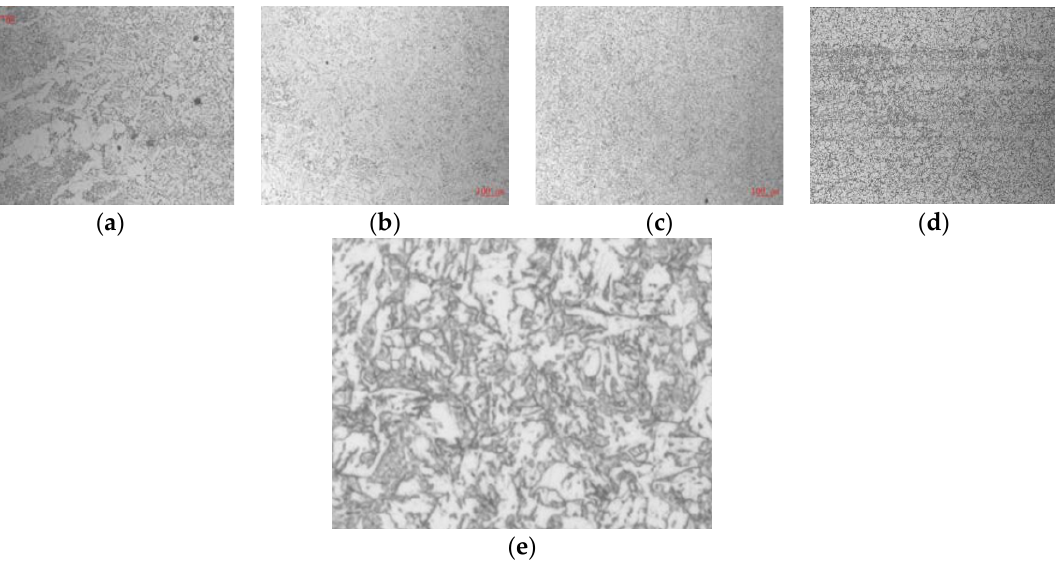
Figure 6. Metallographic structure of HAZ for 16 mm thickness: ( a ), the metallographic structure of welding fusion zone; ( b , c ), the metallographic structure of welding heat affected zone; ( d ), the metallographic structure of the steel plate; ( e ), the higher magnification image of partial area of Figure 6b.